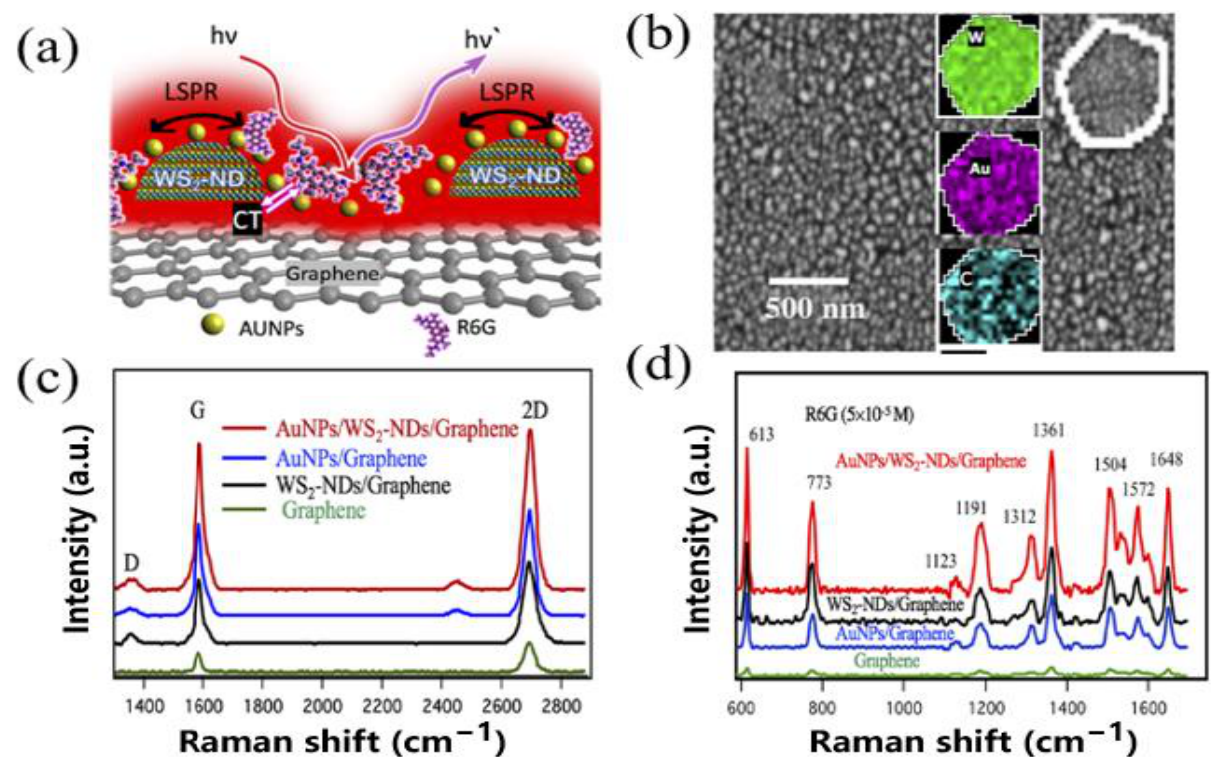
Figure 13. ( a ) Schematic design of the SERS substrate with AuNP/WS 2 − ND/graphene van der Waals (vdW) heterostructure. ( b ) SEM image of an AuNP/WS 2 − ND/graphene sample and EDS maps of W (green), Au (purple) and C (blue). ( c ) Raman spectra of graphene taken on four samples: graphene only (green), WS 2 − ND/graphene (black), AuNP/graphene (blue) and AuNP/WS 2 − ND/graphene (red) using a 488 nm a laser with a power output of 1 mW. ( d ) Raman spectra of R6G molecules at the concentration of 5 × 10 − 5 M deposited on Au NP/WS 2 -ND/graphene(red), WS 2 -ND/graphene heterostructure substrates (black), and AuNP/graphene (blue) with an excitation length of 532 nm. Reprinted from Ref. [63] with permission of 2020 American Chemical